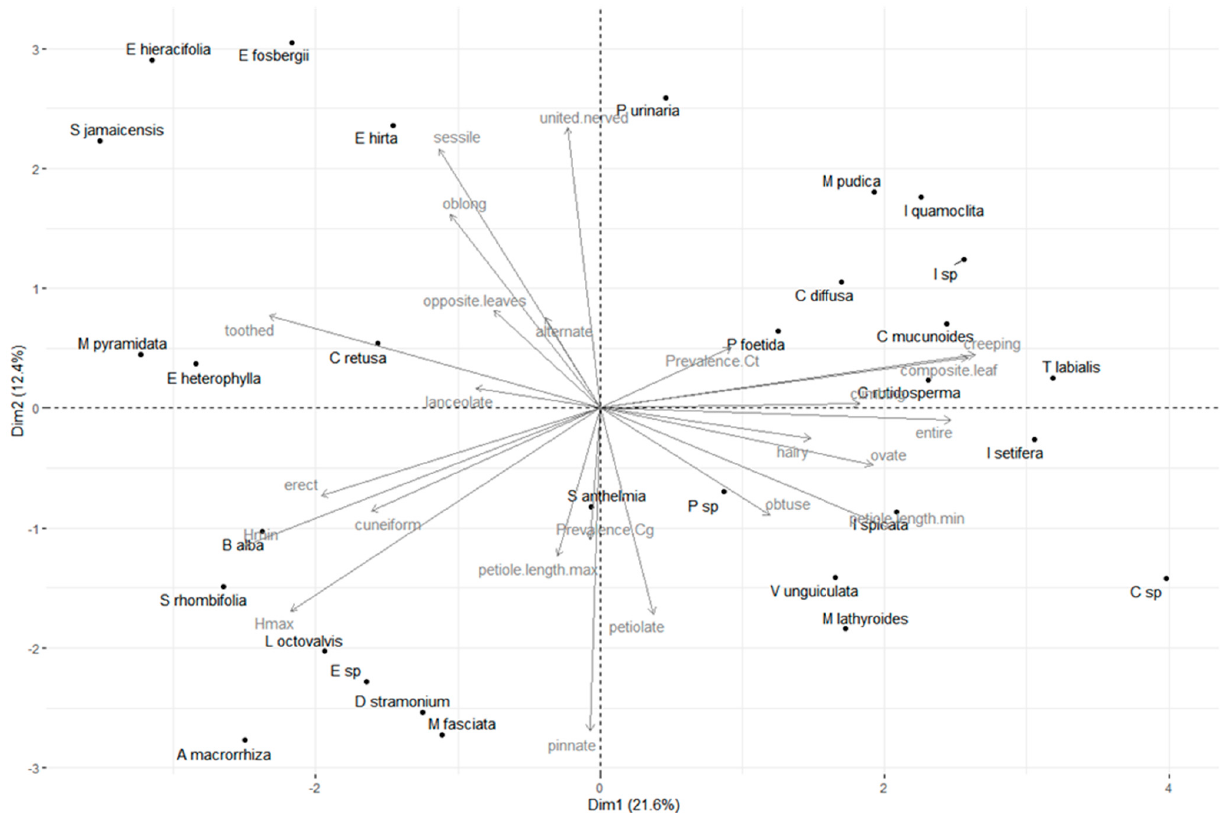
Figure 1. Principal Component Analysis of weed morphospace and prevalence of Colletotrichum gloeosporioides and C. truncatum in post-harvest Yam fields. First axis of PCA retains 21.6% of variance and second axis 12.4%. Morphological characteristics vectors are indicated in